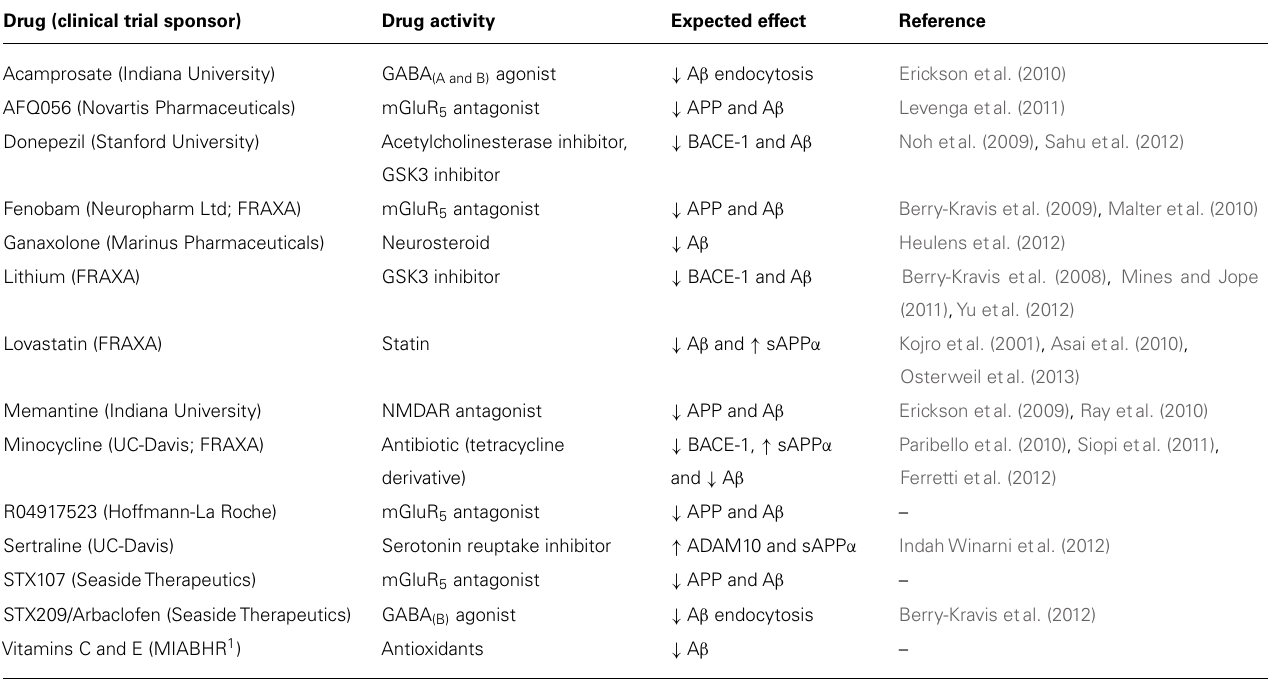
Table 1 | Expected effects of drugs in clinical trials for FXS onAPP,A β , and/or BACE-1. Drug (clinical trial